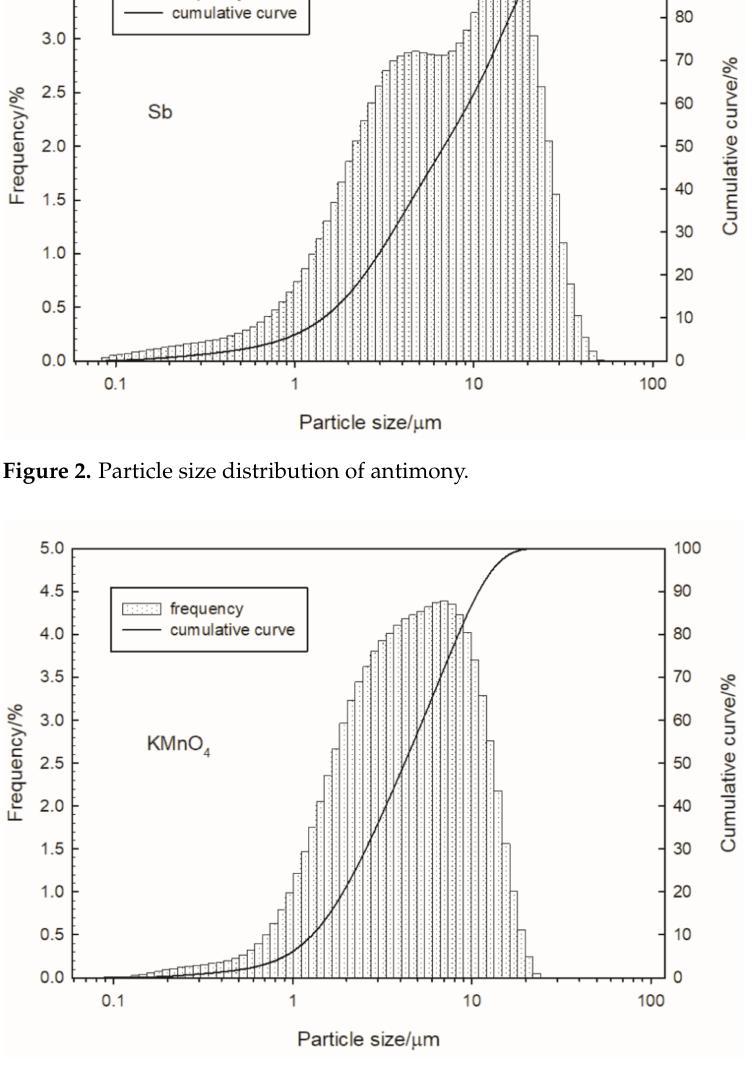
Figure 3. Particle size distribution of potassium manganate